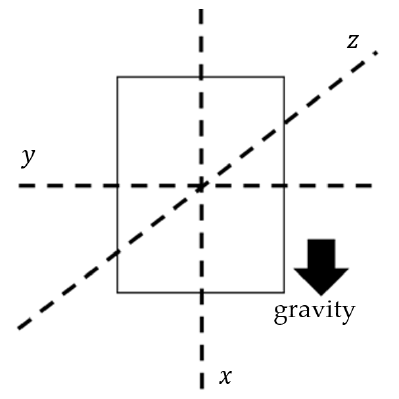
Figure 3. Axes frame of the MDs.